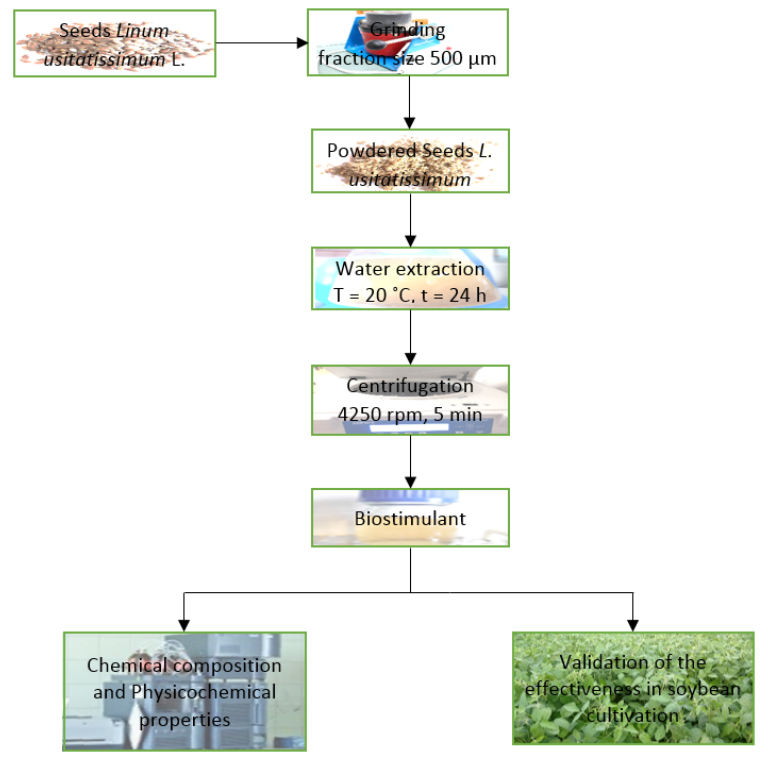
Figure 1. Proposed flowchart of biostimulant production and validation.